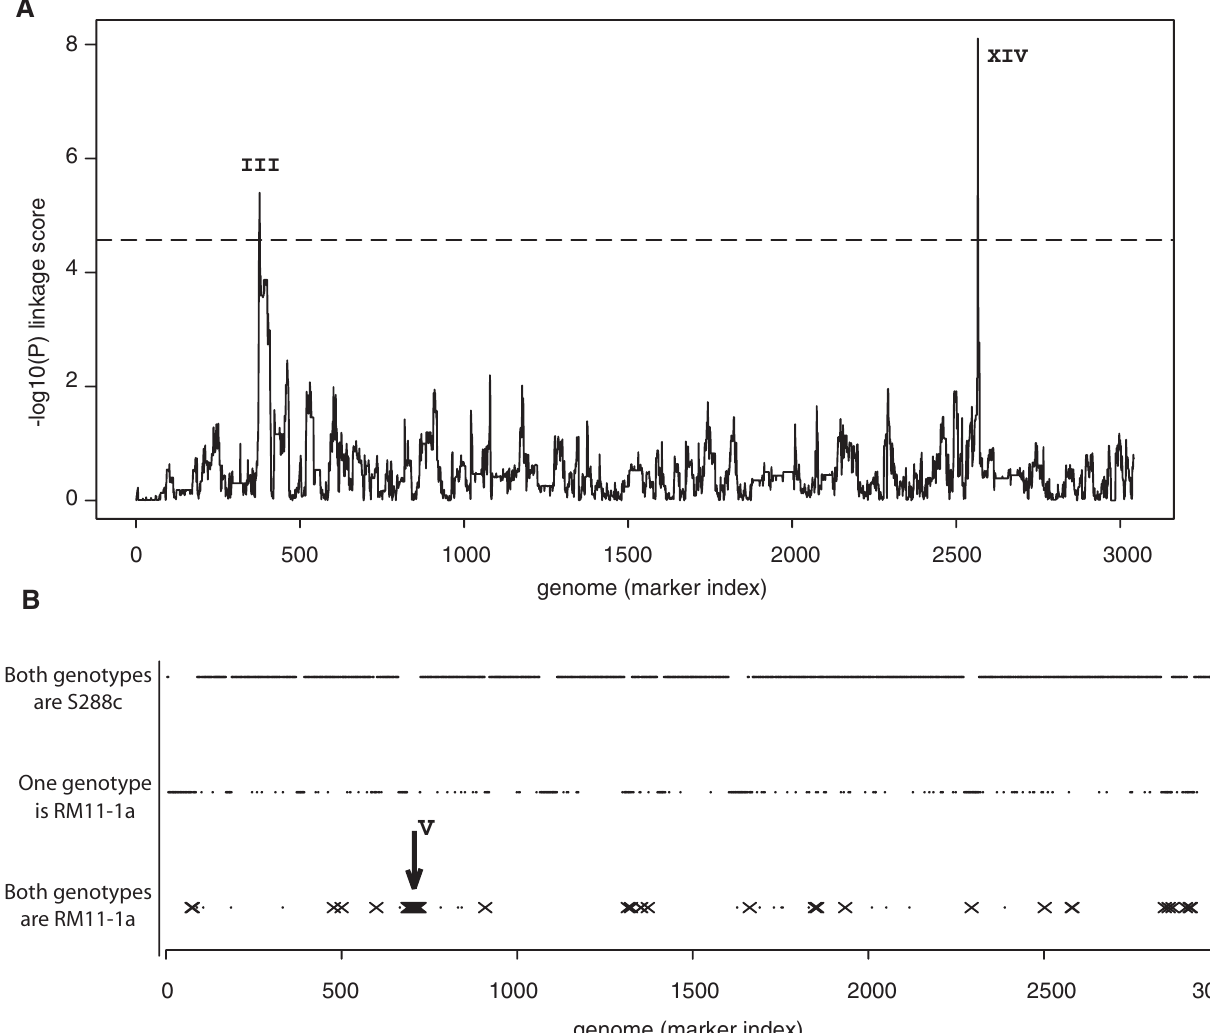
Figure 2. Genome scans for noise QTL. A) Noise levels of P MET17 -GFP from S288c 6 RM11-1a segregants were treated as a quantitative phenotype and genetic linkage was tested at each of 3042 marker positions on the genome. Markers were ordered by their physical position on the reference genome S288c, from chromosome I to chromosome XVI. At every marker, the y-axis represents the -log 10 ( P ) linkage score, where P is the nominal P - value of the test. The dashed line indicates the 1% genome-wide significance threshold. Two significant signals (QTL 1 and QTL 2 ) were found on chromosome III and XIV, respectively. B) Cumulative genotypes of two introgressed strains. Haploid strains GY159 and GY174 were constructed by introgressing high P MET17 -GFP noise level from RM11-1a into S288c. These strains were genotyped at 3015 marker positions using oligonucleotide microarrays. Markers were ordered along the x-axis as in a) and are shown as small dots. The GY159 and GY174 genotypes are presented on three levels depending on whether both strains (bottom), one of them (middle), or no strain (top) inherited the RM11-1a allele of the marker. Among the bottom genotypes, markers that where also inherited from RM11-1a in strain GY157 (the S288c 6 RM11-1a segregant with highest noise) are marked by crosses. These positions are candidates to contain RM11-1a alleles conferring high noise. A cluster of such candidate markers was found on chromosome V (arrow).